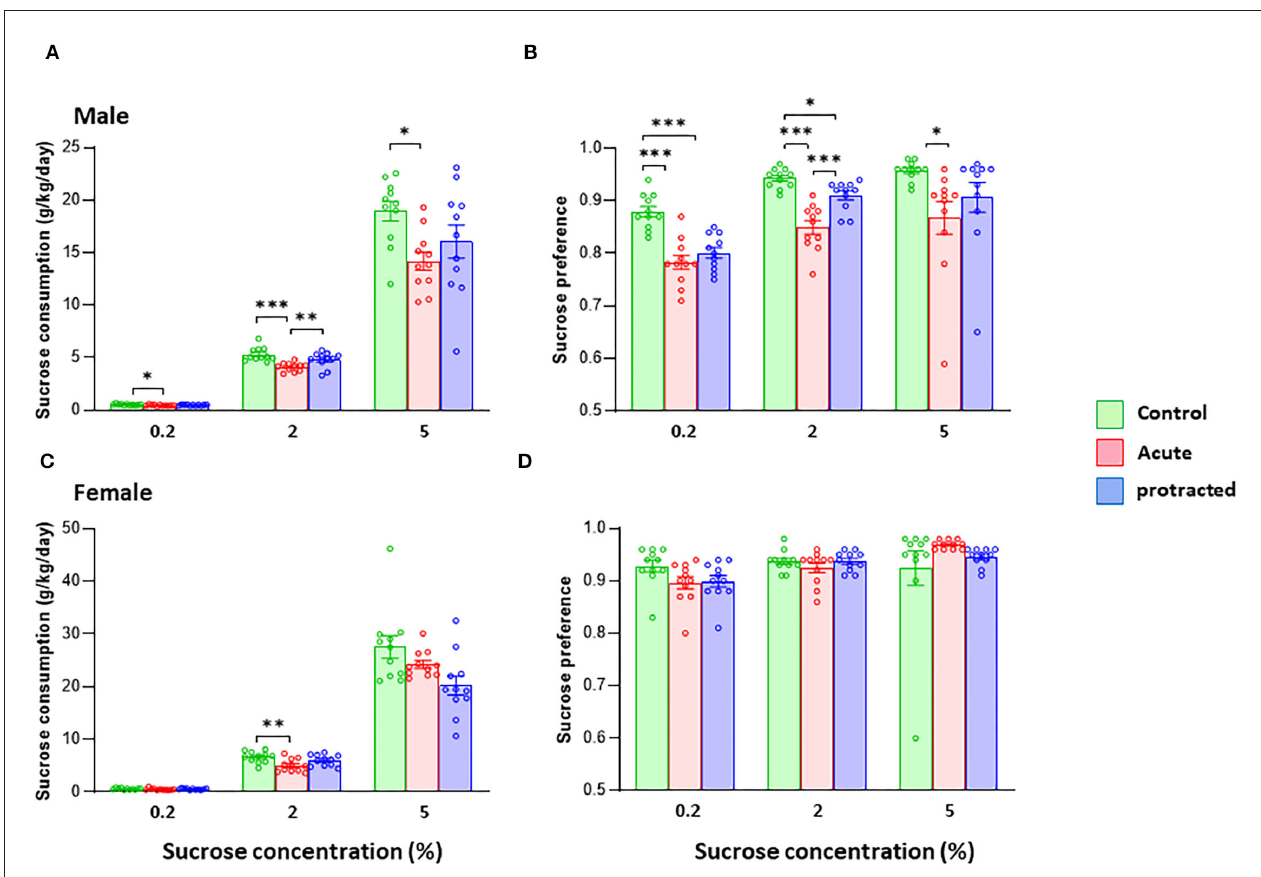
FIGURE 6 | Protracted and acute prenatal stress induces anhedonia-like behaviors in young male and female adult offspring at age of postnatal day 70. The sucrose consumption was measured using two-bottle free-choice paradigm. (A,B) Present that the sucrose intake (g/kg/day) of the tests for both male and female rats. The consumption (A) and preference (B) to the 3 given concentrations of sucrose were significantly decreased in male rats from protracted and acute groups, in which the rats in acute group exhibited the most significant reduction as compared with control group, * p < 0.05, ** p < 0.01, *** p < 0.001: Protracted, Acute vs. Control; # p < 0.05, ## p < 0.01: Acute vs. Control. In female rats, acute stress group showed significant less in sucrose consumption (C) only at 2% sucrose. There was no difference in sucrose preference among three groups (D) , 2-way repeated ANOVA followed by Bonferroni test, n = 11 for each group. Values are the mean ± SEM. Individual value is shown with circle dot on bar